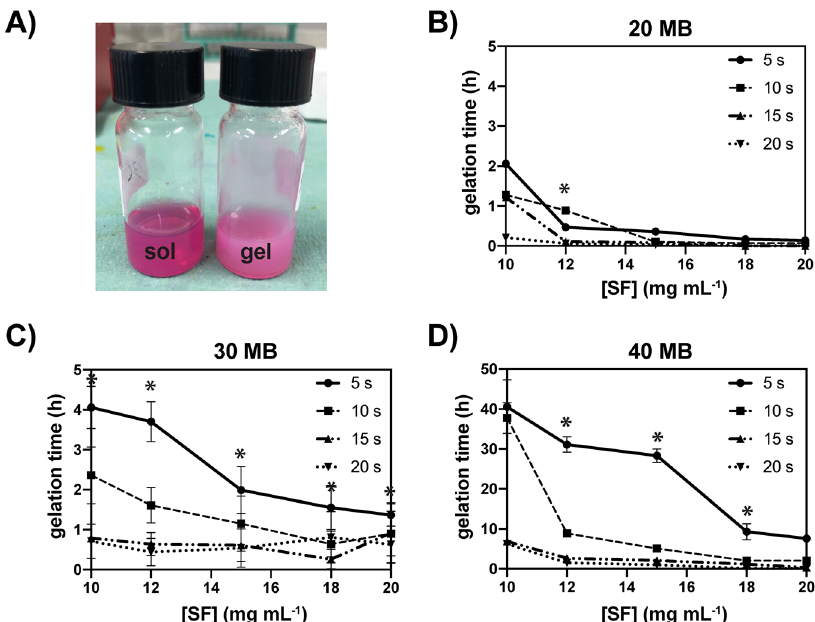
Fig. 2 SF gelation time under various sonication conditions. A Representative SF solution and hydrogel prepared in DMEM. B – D Gelation time of SF solutions prepared in DMEM at different SF concentrations (from 10 to 20 mg mL − 1 ) and boiling times (20, 30, and 40 MB). The different SF aqueous solutions were sonicated at 30% amplitude for different sonication times (5, 10, 15, and 20 s). Data are expressed as mean ± SD (* p < 0.05 among different sonication periods). The sol-gel transition was monitored by visual inspection of the